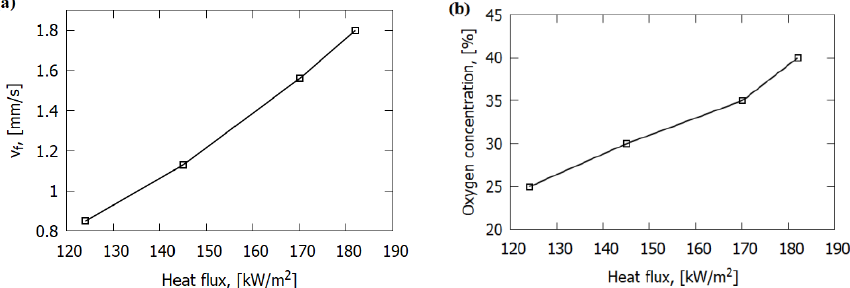
Figure 8. Dependence of the maximum calculated heat flux from the flame to the surface of the 0.3 mm-thick sample on the ROS ( a ) and on O 2 concentration ( b ).